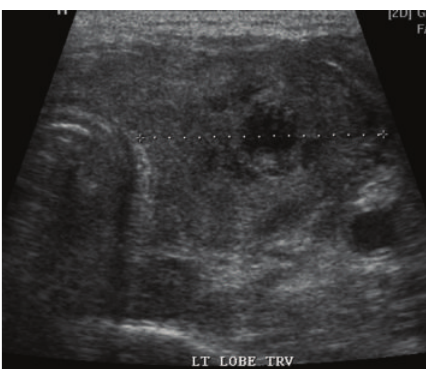
Figure 2: Thyroid sonogram showing a 3.7 × 2.5 × 2.9 cm oval heterogeneous structure, in the left lobe.